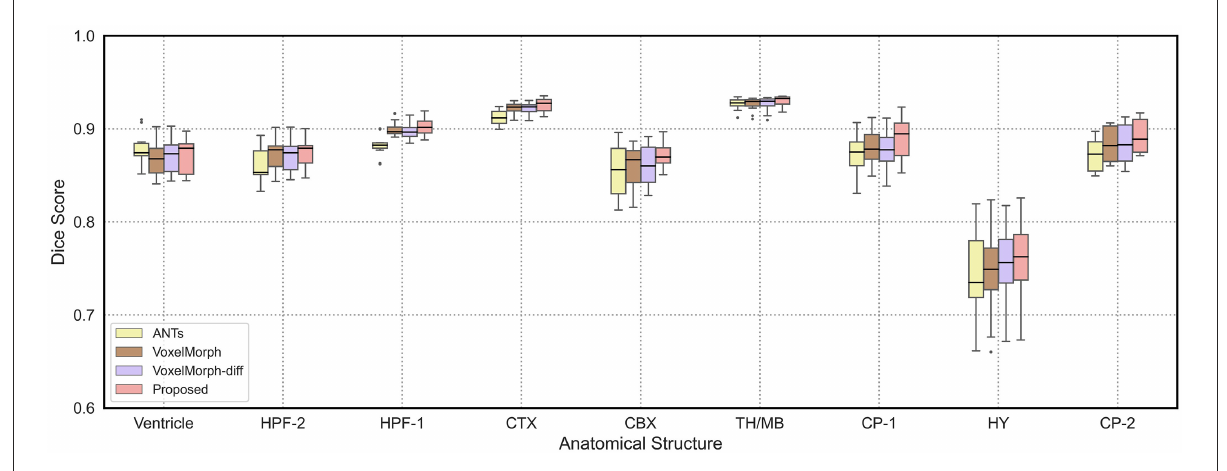
FIGURE4 The boxplots of average dice scores of nine anatomical structures in mouse brain. We show the results of ANTs, VoxelMorph, and VoxelMorph-diff compared with our proposed method. We also mark the median values of test results with black horizontal lines.